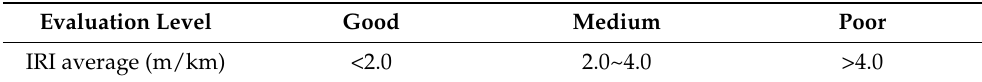
Table 1. Airport pavement IRI grading